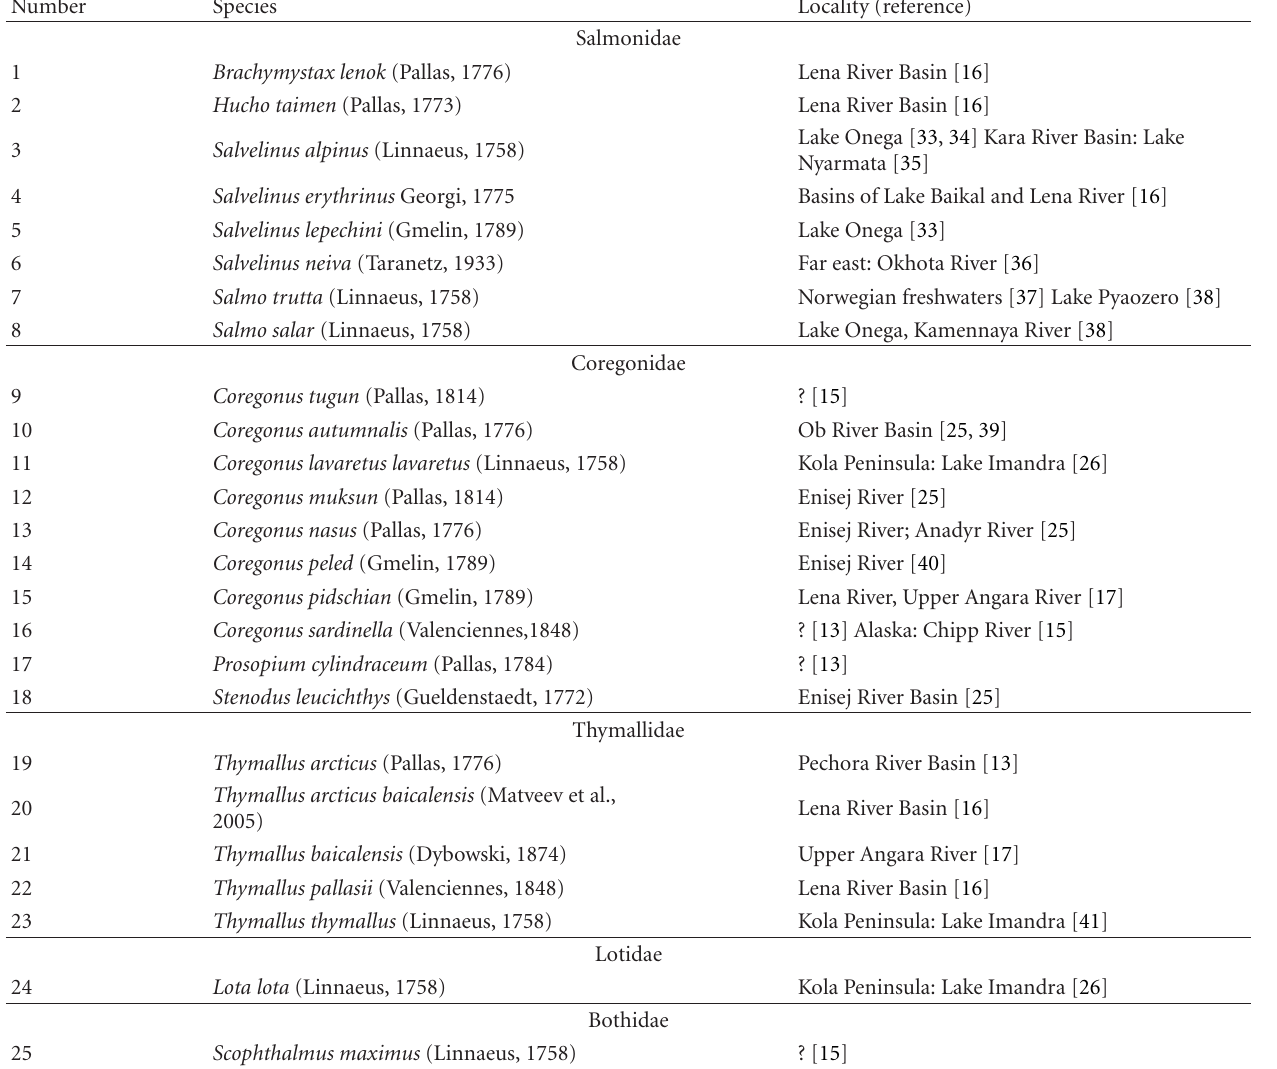
Table 4: List of fish species and subspecies, which are parasitized by A.